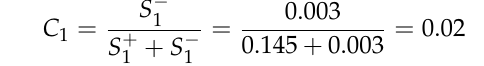
Table 6. The estimations of S +